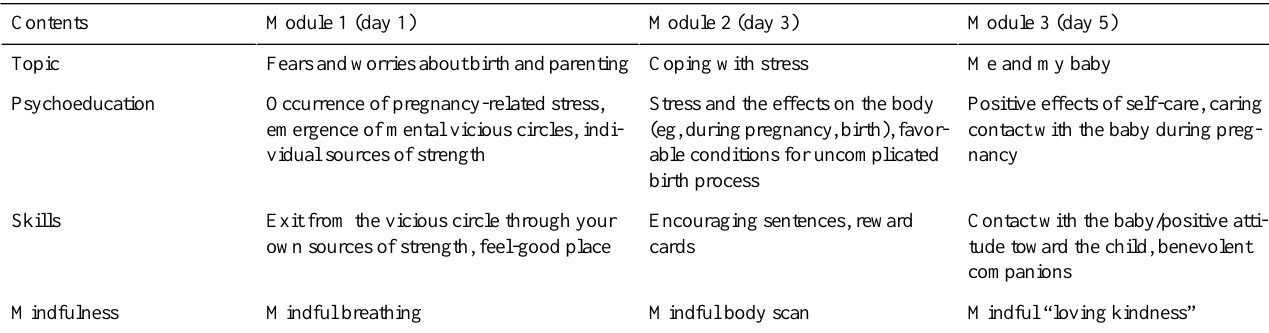
Table 1. Overview of the mindmom app content.